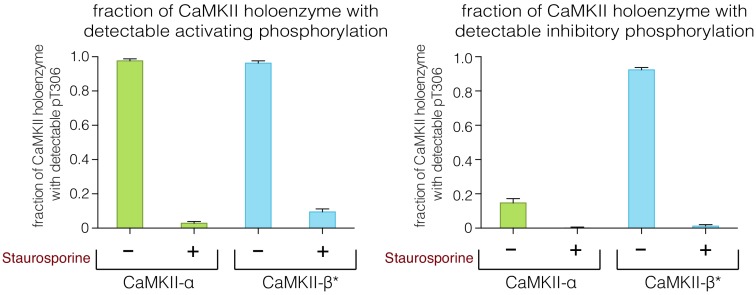
Inhibition of CaMKII kinase activity by staurosporine.Fraction of CaMKII-α/β* holoenzymes with detectable phosphorylation at Thr 286 (left) and Thr 305/306 (right) after 60 min of treatment with the activation buffer (see Materials and methods) in the absence and presence of 100 μM staurosporine.